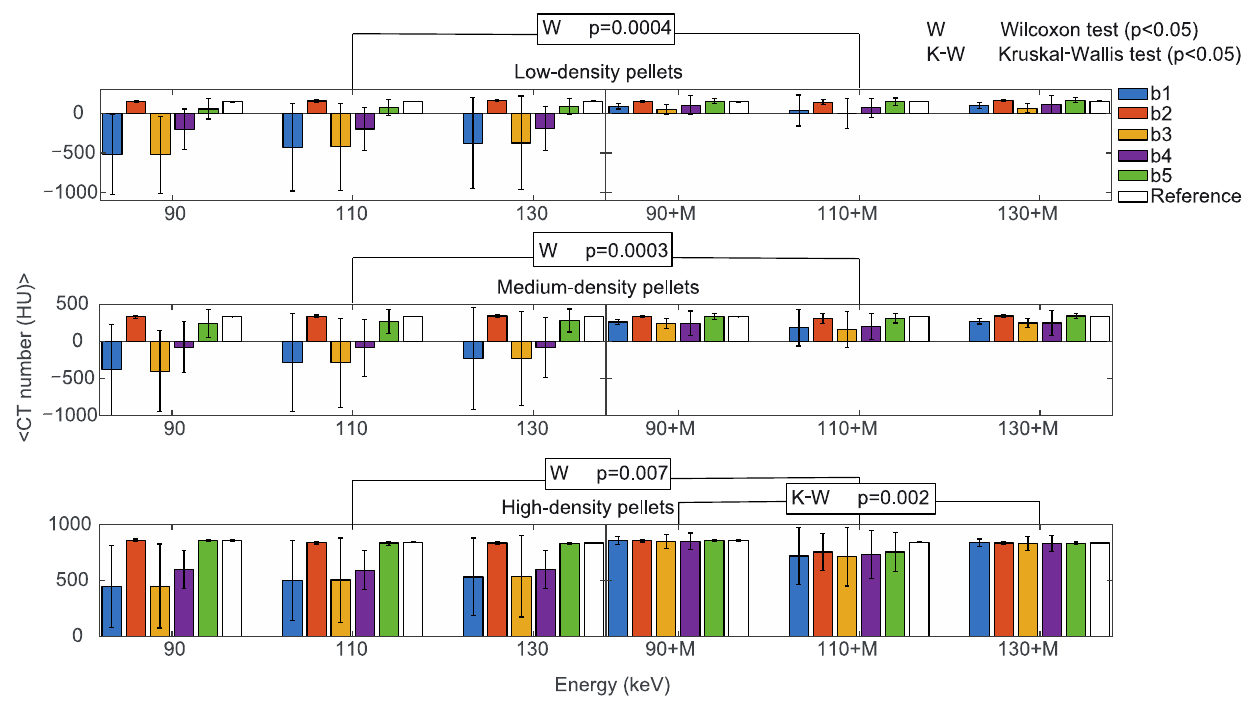
Figure 6. Mean CT numbers of VMI without (90, 110, 130) and with the MARS algorithm (90+M, 110+M, 130+M) for all the prosthetic configurations. Values are reported for pellets with low (upper), medium (central), and high (lower) density in positions b1, b2, b3, b4, and b5 indicated in blue, orange, yellow, purple, and green, respectively. The reference values are indicated in white. The statistically significant values of the Wilcoxon (W p < 0.05, to determine the effect of the MARS application) and Kruskal-Wallis (K-W p < 0.05, to determine the effect of changing the reconstruction energies, either with or without MARS) tests are also